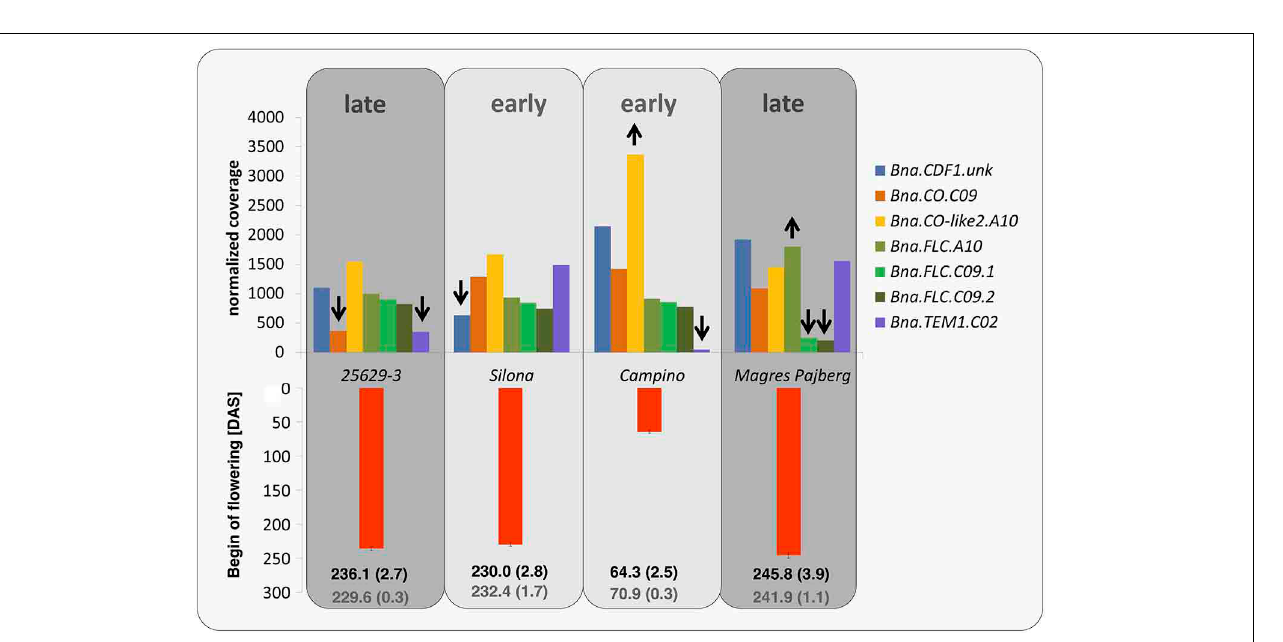
years and 3 locations in Germany (with standard errors). In the field trials in Germany 25629-3, Silona and Magres Pajberg were tested in autumn-sown trials, whereas the winter-sensitive Campino was grown in a spring-sown trial. The black numbers indicate the genotype mean (with standard error), while the gray numbers indicate the population mean (with standard